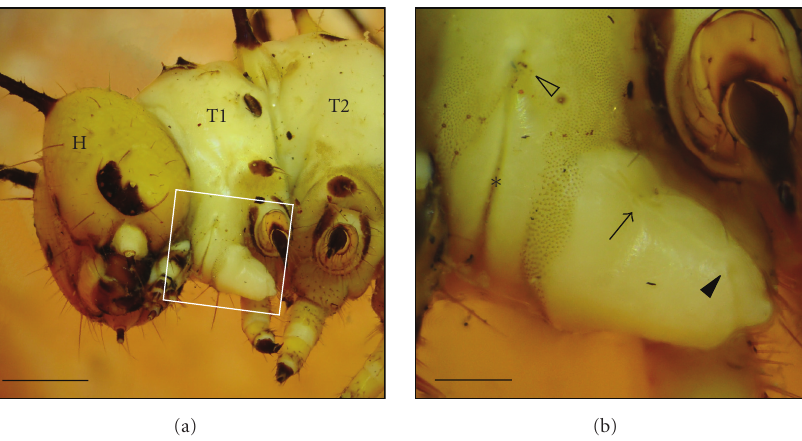
Figure 1: Latero-external view of the larval prosternal glands of the fifth instar of Heliconius erato phyllis , under light microscopy. (a) Midventral location in relation to the body (in rectangle). (b) Lateral view in detail (enlarged rectangle shown in (a)), indicating the openings of the impair (asterisk) and left paired (arrow) glands, and the insertion positions of the corresponding retractor muscles (open and closed arrowheads, respectively). (H) head; (T1) prothorax; (T2) mesothorax. Scale bars = 200, 100 µ m, respectively.